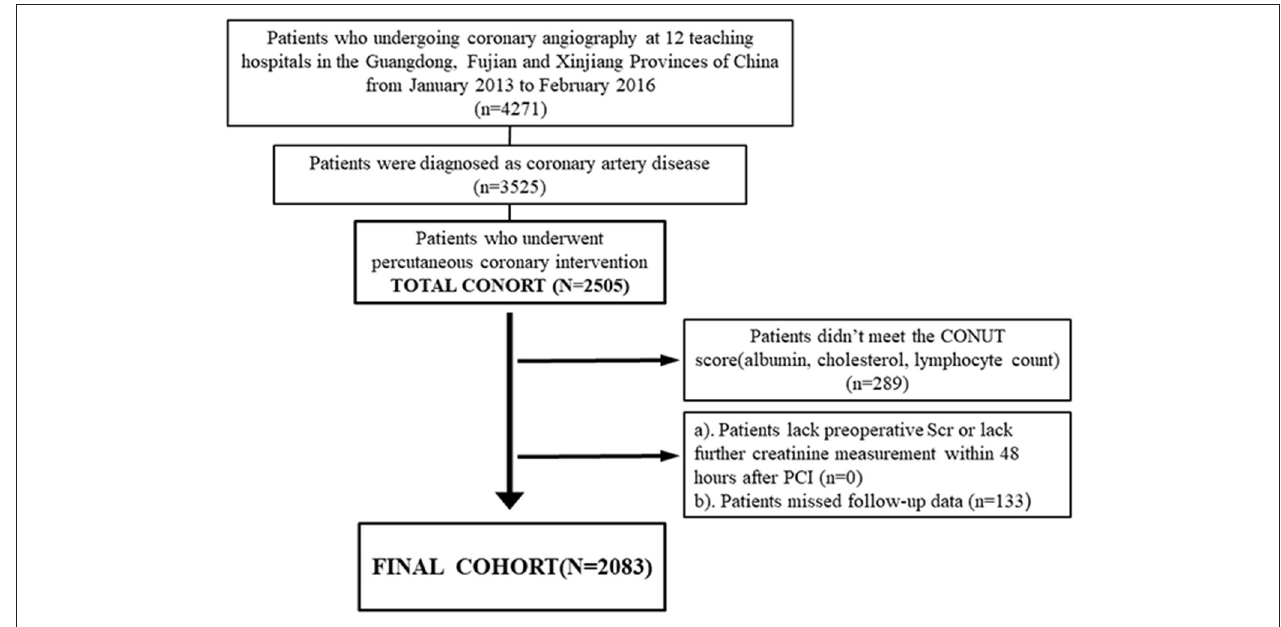
FIGURE 1 | Patient flow